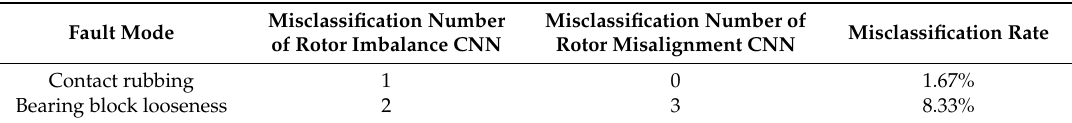
Table 6. Misclassification numbers and rates when displacement data of contact rubbing and bearing block looseness are presented for displacement CNNs.